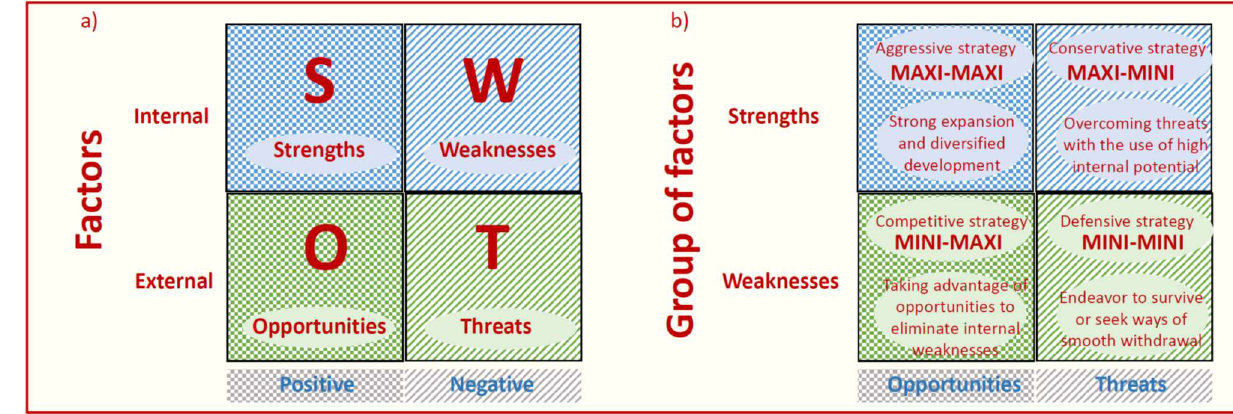
Figure 5. Scheme of the SWOT (strengths–weaknesses–opportunities–threats) analysis: ( a ) the considered factor groups; ( b ) the recommended strategies of activity concerning the analysed groups of technologies.